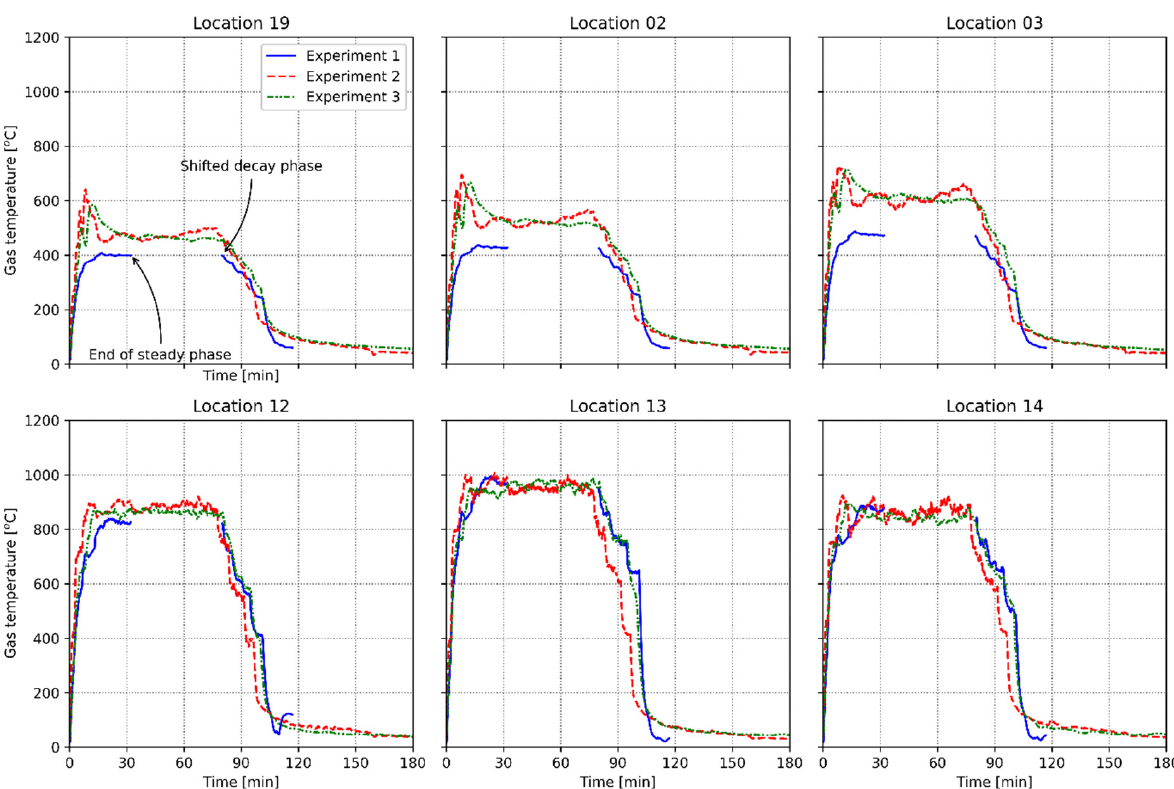
Figure 13. Ceiling gas-phase temperatures for all experiments.